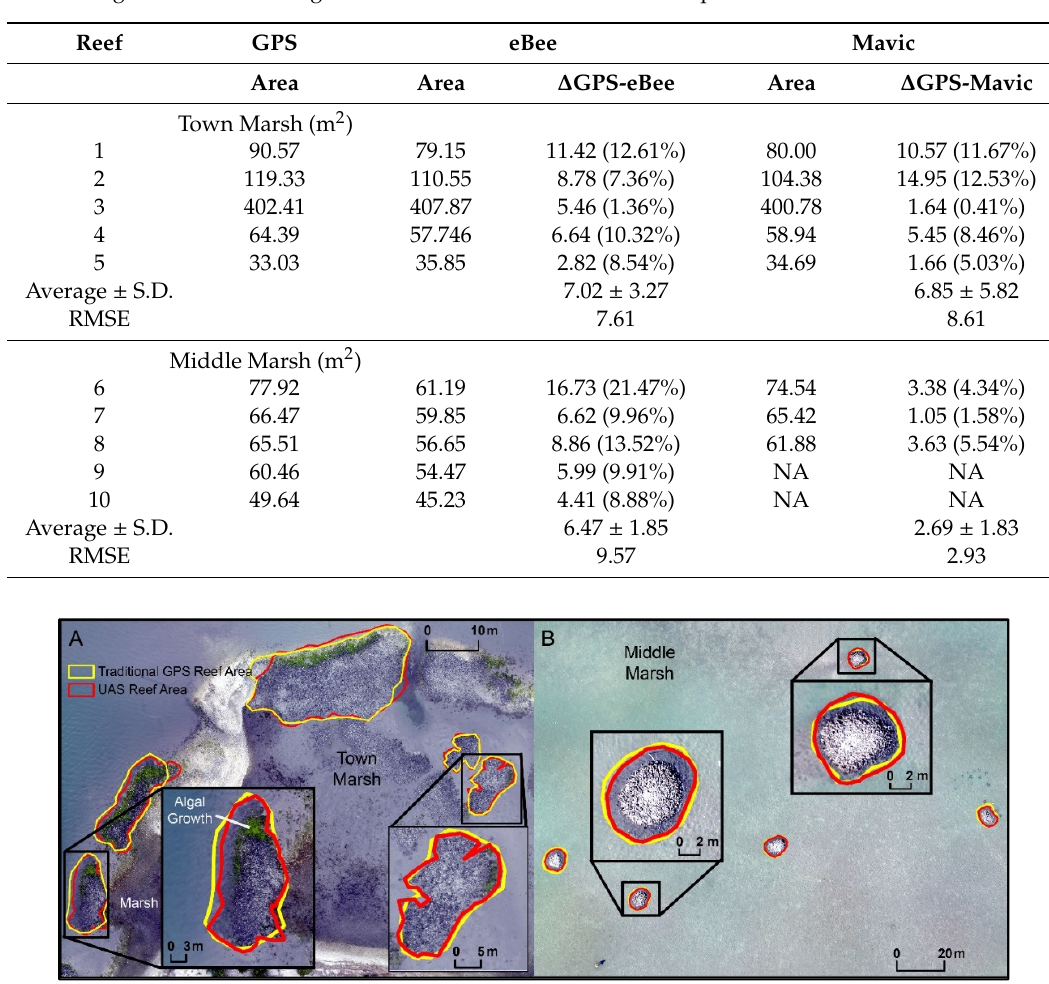
Table 1. Global positioning system (GPS) and unoccupied aircraft system (UAS)-derived intertidal oyster reef area measurements in m 2 from five reefs located in Town Marsh and Middle Marsh. Only three intertidal reef area measurements are included in the Mavic flights at Middle Marsh due to a small flight extent. Percentage of reef area di ff erences are shown in parentheses.